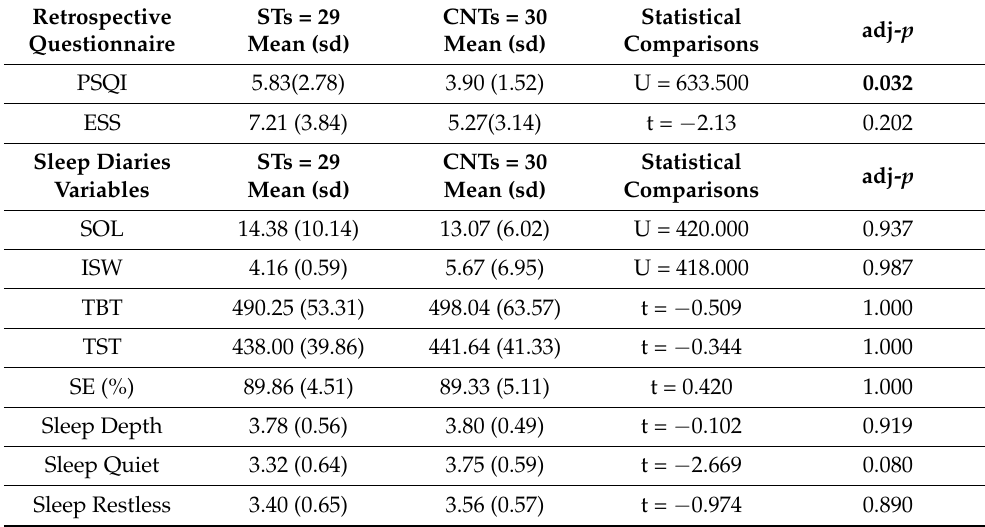
Table 2. Comparisons results of retrospective and longitudinal sleep measures (sleep